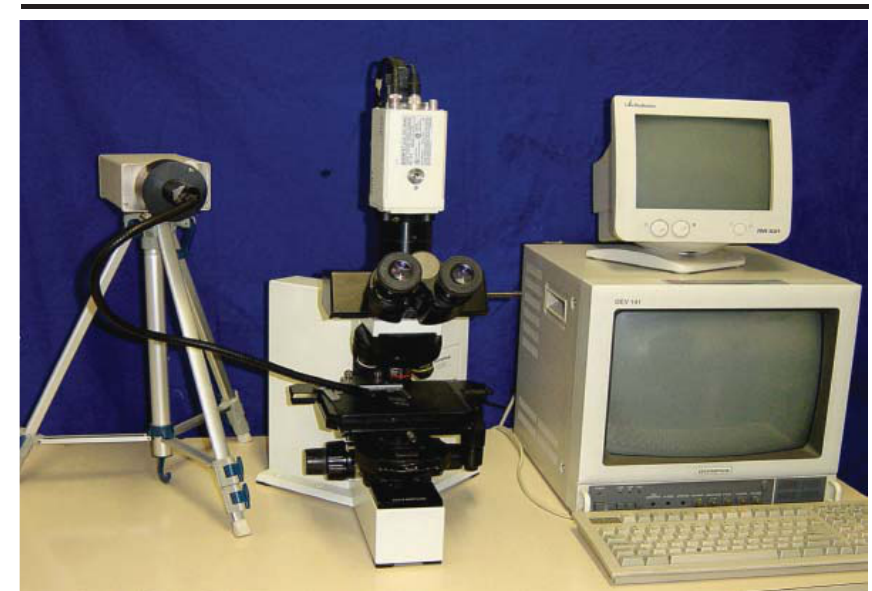
FIGURE 1 - Stroboscope lamp coupled to the microscope equipped with an image- capturing